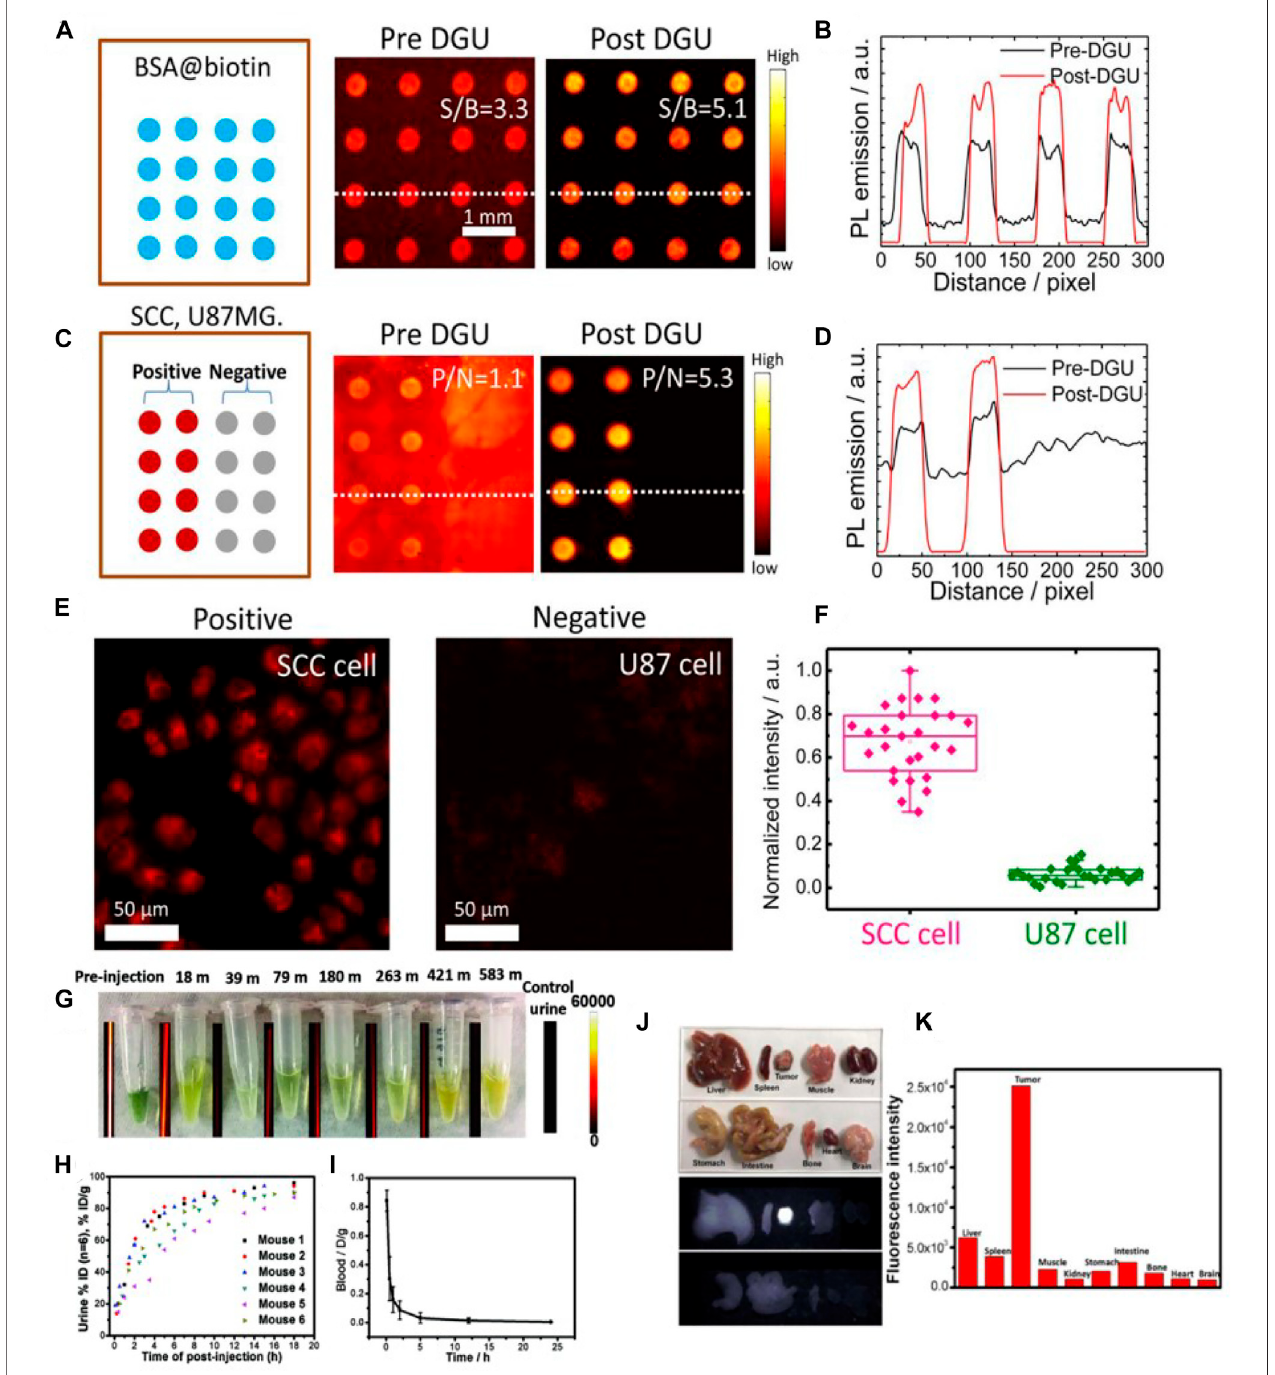
FIGURE 2 | The microarray assay screening method developed to test the conjugates. (A) Assay analysis of DGU fraction of SA@IR-FGP. (B) Cross-sectional intensity pro fi le of the spot signal. (C,D) Assay analysis of the DGU fractions of Erb@IR-FGP. SCC and U87 cell lysates were printed on plasmonic fl uorescence- enhancing gold slides for testing the conjugate Erb@IR-FGP. (E) Targeted cell staining by Erb@IR-FGP (SCC and U87 cell lines as positive and negative controls) scanned by a home-built microscope with 785 nm excitation and a 1,050 nm long-pass emission fi lter. (F) PL intensity statistic of SCC and U87 cells (reproduced from (Zhu et al., 2017) with permission from National Academy of Sciences.) (G) Collections of urine of mice injected with NIR-II fl uorophore IR-BGP6 and their corresponding fl uorescenceimages. (H) Quanti fi cationofrenalexcretionofIR-BGP6bycalculationofitsamountinurine. ≈ 91%IR-BGP6 canberenallyexcreted within the fi rst 10 h p. i. (I) The blood circulation behavior of IR-BGP6. The fast-renal excretion of IR-BGP6 corresponded to the short blood circulation half-life time ( ≈ 24 min). (J) Major organs and tumors taken from mice injected with anti-PD-L1-BGP6 at 24 p. i. and their corresponding fl uorescence imaging in the NIR-II window ( > 1000 nm). (K) Quanti fi cation of biodistribution of anti-PD-L1-BGP6 (reproduced from (Wan et al., 2018) with permission from Wiley-VCH Verlag GmbH and Co. KGaA, Weinheim).